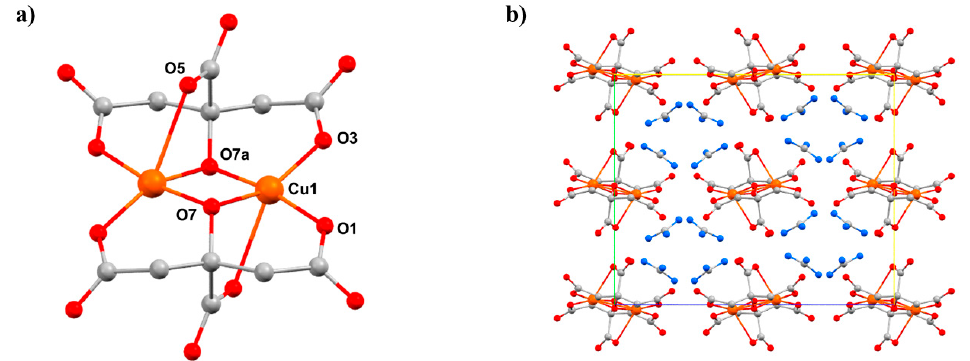
Figure 11. ( a ) The molecular structure of the anion in 8 . ( b ) Crystal packing of complex 8 along the a -axis. Colour code: Cu = orange, O = red, N = blue, C = grey. H atoms and counter ions (in ( a )) are omitted for clarity.